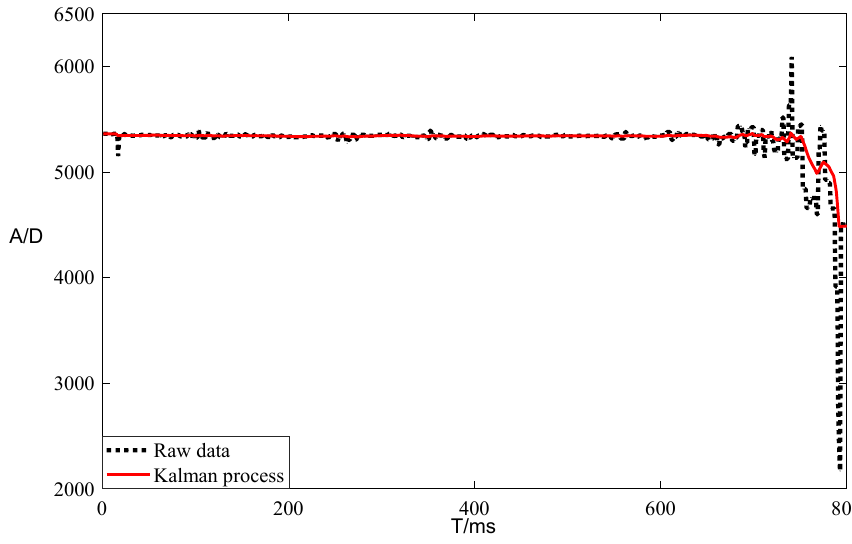
Figure 10. The rendering of the Kalman fi lter.